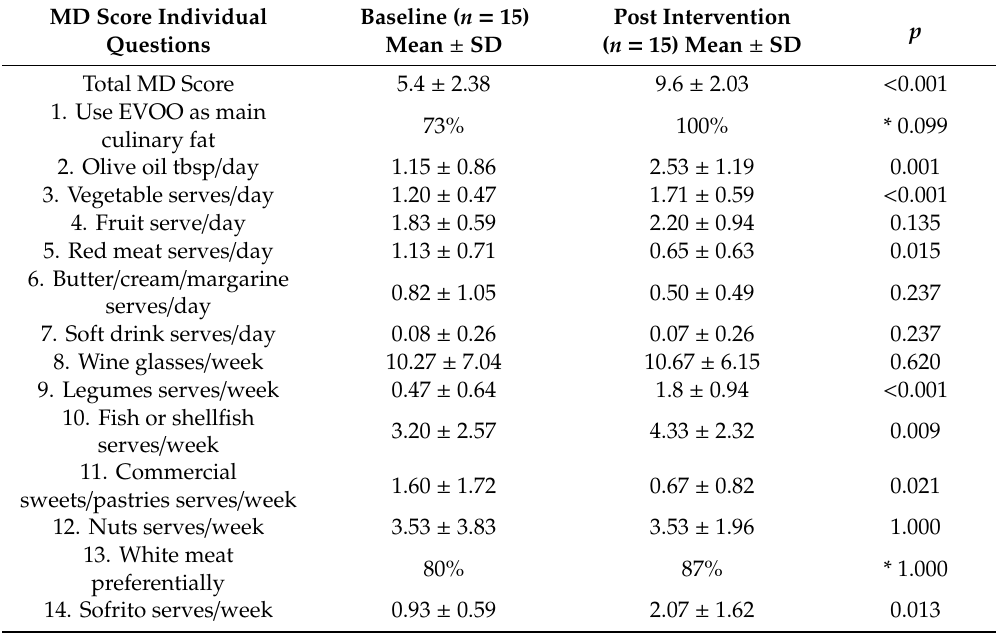
Table 3. Mean change in intake of 14-point MDS baseline to post intervention.